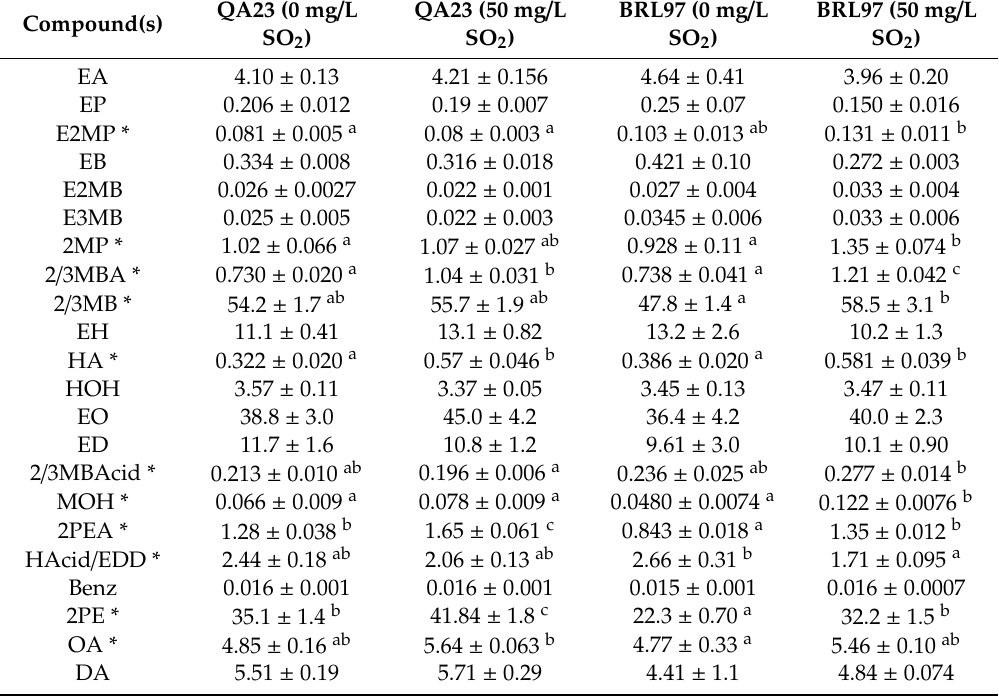
Table 3. Relative quantity ( ± SEM) of volatile compounds in wines fermented by di ff erent commercial yeast strains and in the presence of di ff erent sulfite levels ( n = 4 per treatment). Compounds with